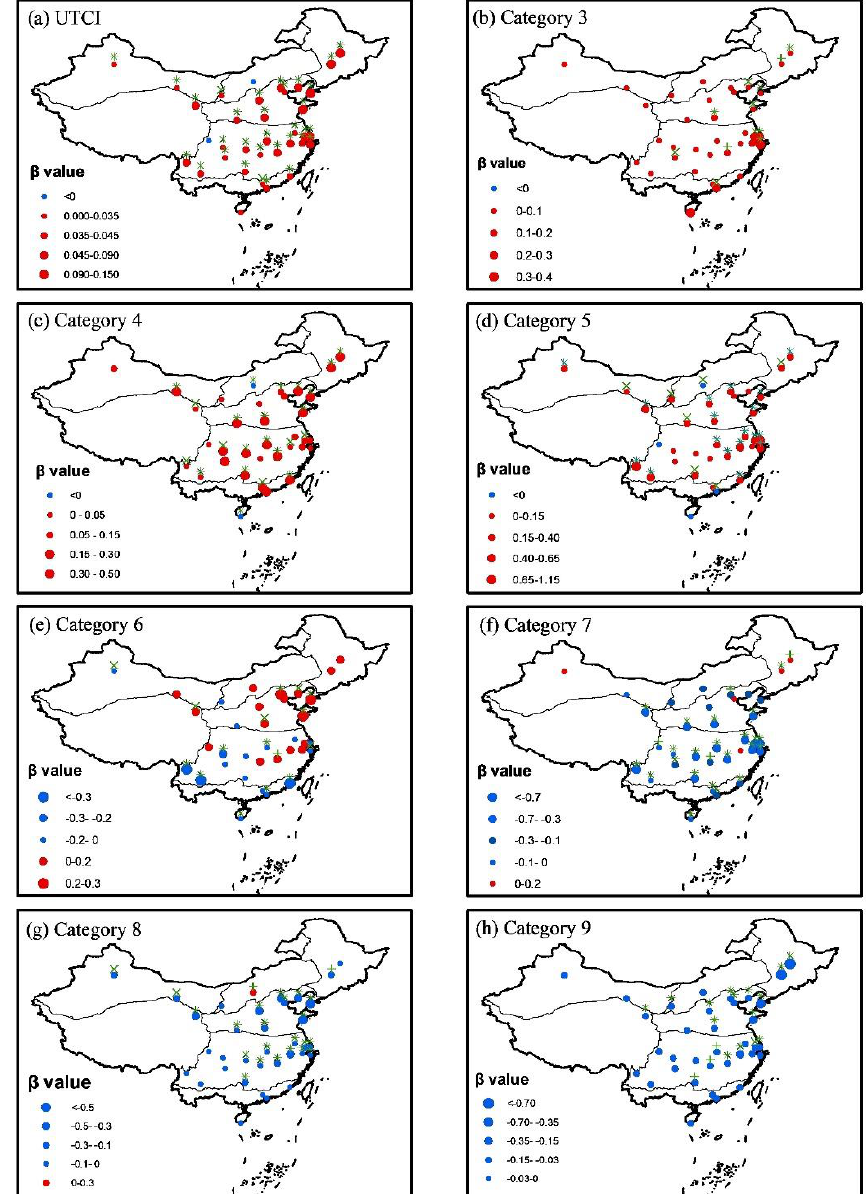
Figure 6. Trend analysis of the changes in yearly day number within each category from 1961 to 2020. Plus +, multiple × , and asterisk * signs denote confidence levels of 90%, 95%, and 99%, re- spectively.